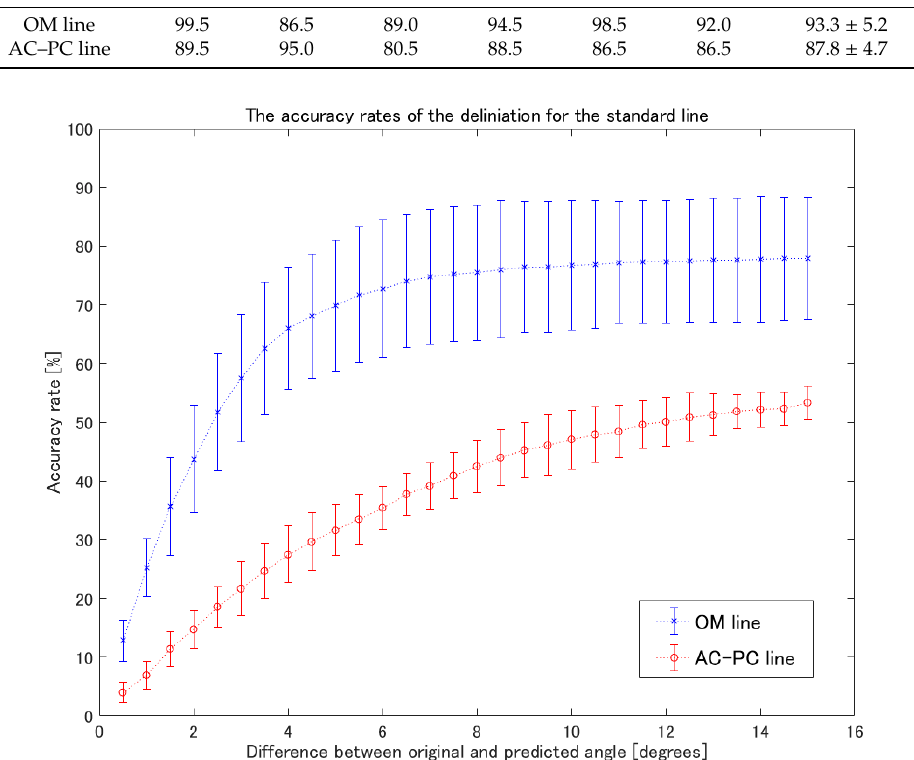
Table 3. Detection rates of the standard line for brain MRI. Table 4. The processing speeds of calculating the standard line.